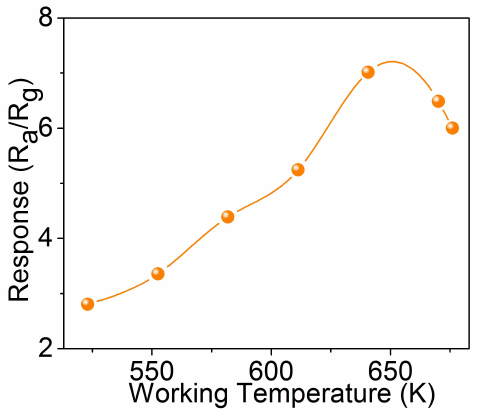
Figure 5. Relationship of responses vs. the operating temperature of the 3DIO WO 3 gas sensors to 5 ppm acetone. The lines are spline